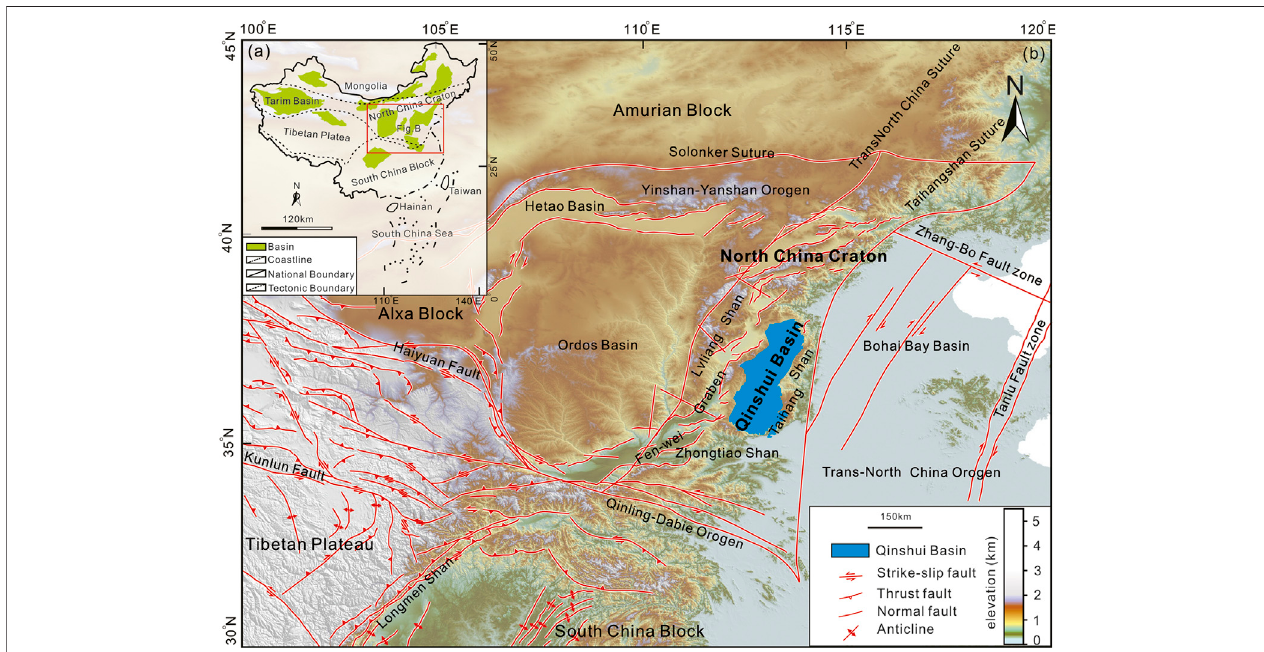
FIGURE 1 | Geological Setting of Qinshui Basin (A) Tectonic and basin map of China. Structures are modi fi ed from (Yang et al., 2018, 2021a) (B) Regional topographicandneotectonicmapofNorthChina.Structuresaremodi fi edfromYeetal.(1987);Dengetal.(1987);QiandYang,(2010),Zhangetal.(2019),andSuetal. (2021). Red boxes show the location of the study areas. (B) Distribution map of North China Craton and Qinshui Basin.